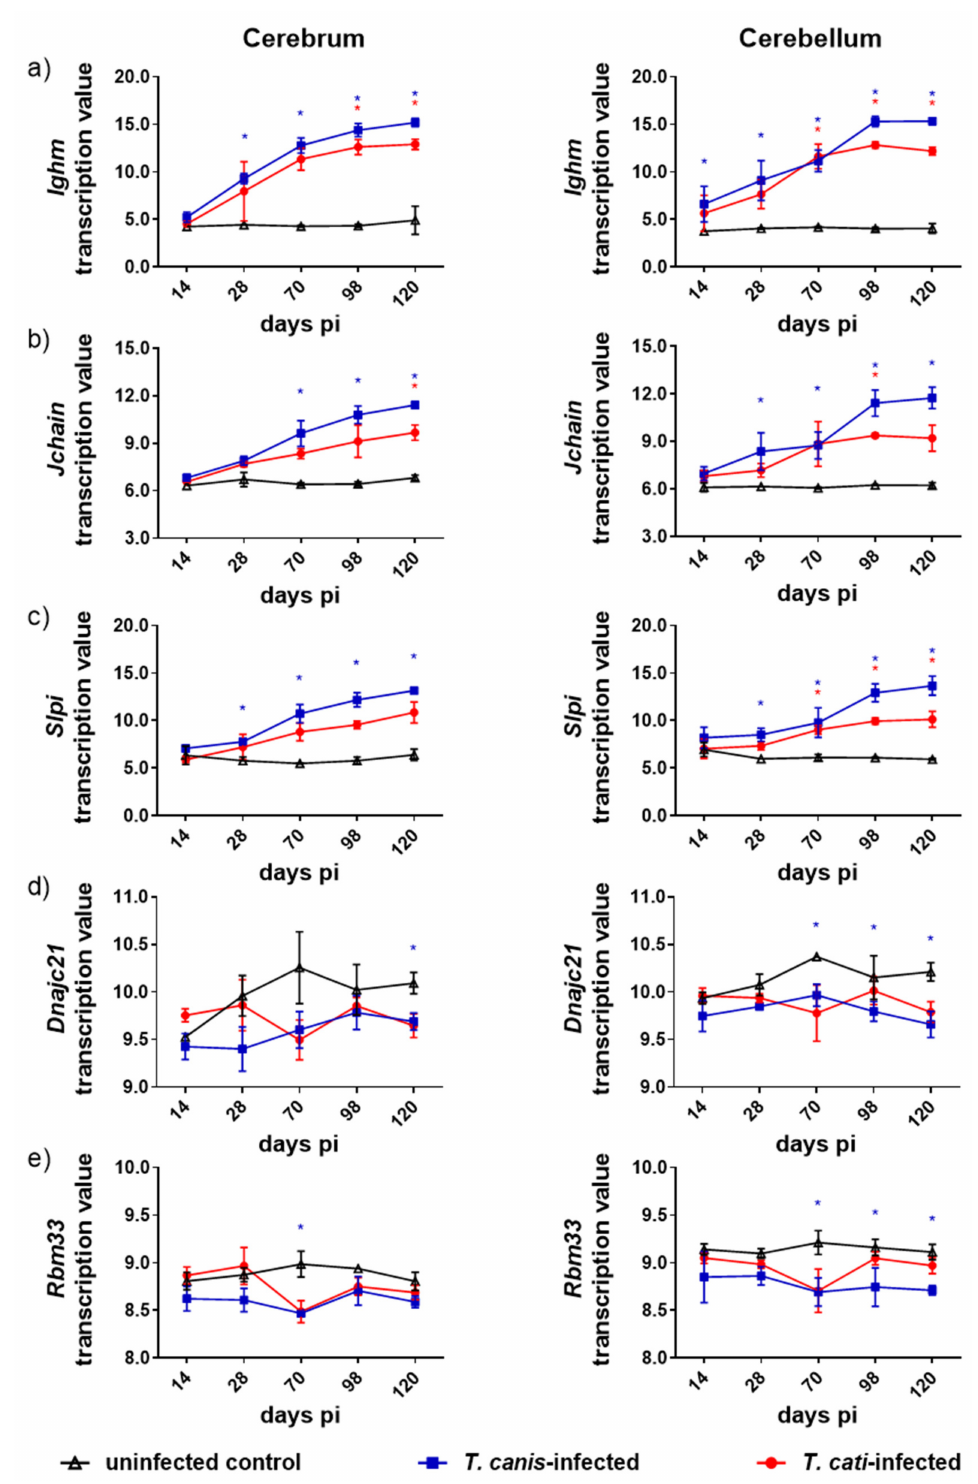
Figure 4. Transcriptional values of the five genes ( a ) Ighm , ( b ) Jchain , ( c ) Slpi , ( d ) Dnajc21 , and ( e ) Rbm33 differentially transcribed in the cerebra and cerebella of both Toxocara. canis - and T. cati -mice at different days post infection (pi). Asterisks indicate statistically significant differences ( p ≤ 0.05) between infected and uninfected mice according to the color